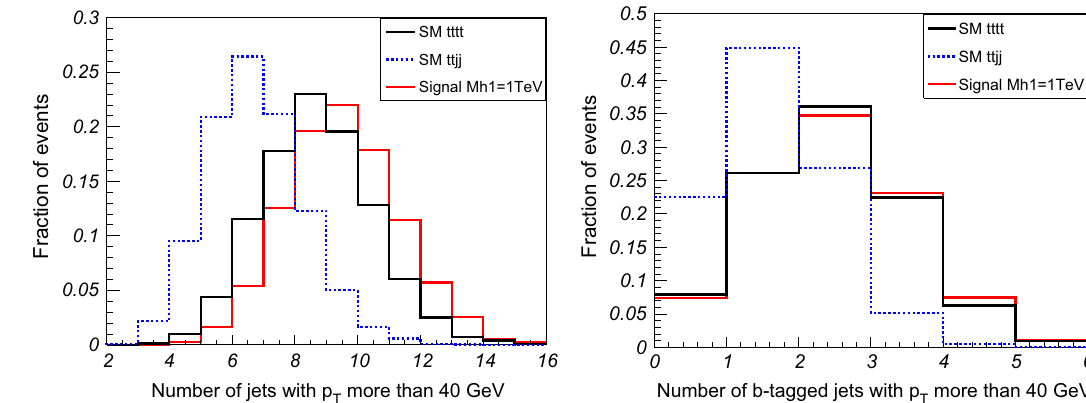
Fig. 1 Number of jets to the left and the number of b-tagged jets as a discriminating variable to the right